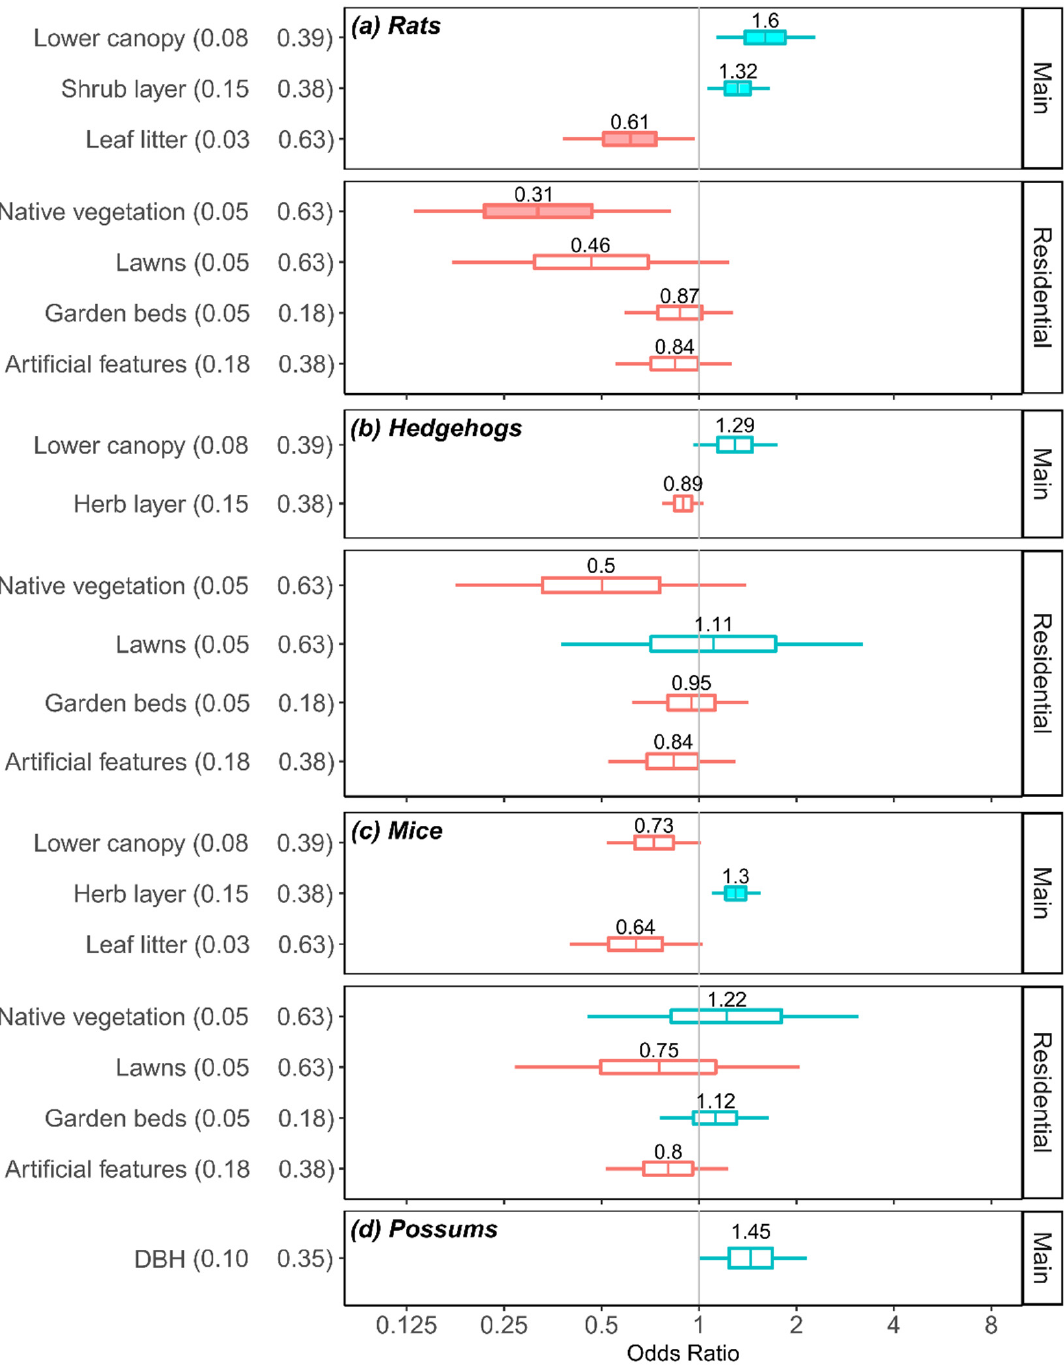
Figure 4. Practical significance of continuous covariates in the main models and residential models of four mammalian taxa: ( a ) rats, ( b ) hedgehogs, ( c ), mice, ( d ) possums (no residential model fitted). Boxplots show the posterior distribution of odds ratios (OR) for a predicted change in detection odds. The OR are estimated from the difference in predicted detection odds at the 25% vs. 75% quartiles of each covariate; these quartile values are given after each parameter name. Median OR displayed above each box, interquartile range is 25–75% of distribution, and tails cover 90% of the distribution (5–95%). The grey vertical band lies at OR 1 (no effect), blue distributions are net positive effects, red distributions signify negative relationships, and shaded boxes represent significant effects (i.e., 90%CI of OR does not include 1).